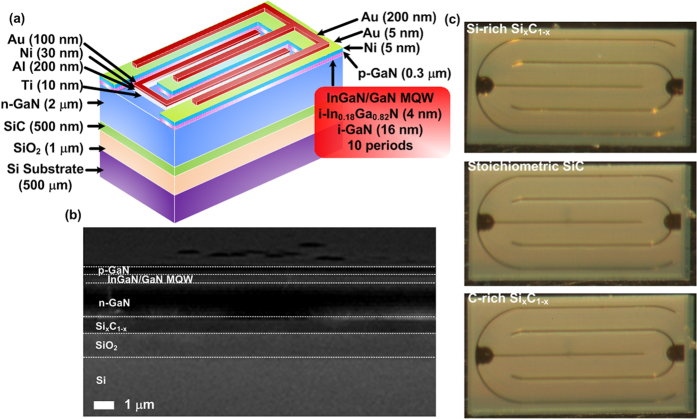
The structure of the GaN LED on SiC/SiO2/Si substrates.(a) The structure diagram of the GaN LED on SiC/SiO2/Si substrates (b) The SEM image of the GaN LED devices grown on the SiC/SiO2/Si substrate. (c) The photograph of the GaN LED devices grown on the SiC/SiO2/Si substrate with Si-rich (Upper), the stoichiometric (Middle), and C-rich (Lower) SixC1−x films.